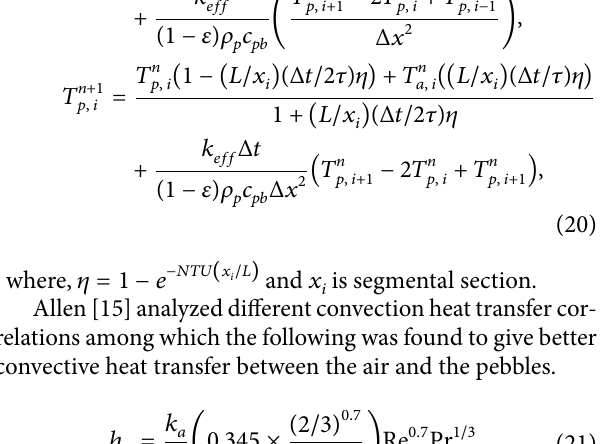
and indicates the current 𝑛 𝑛 + 1